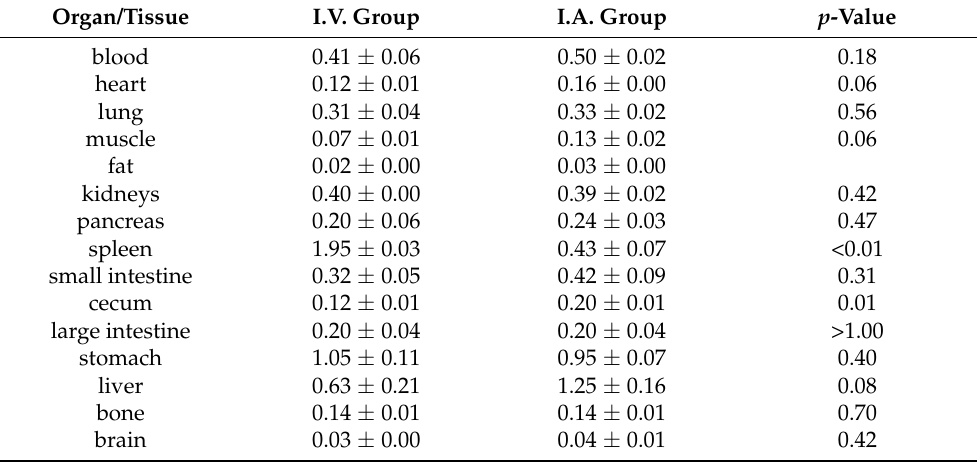
Figure 4. Comparative biodistribution of [ 124 I]I-UC-MSC-EVs for the I.V. group vs. the I.A. group after PET-CT scanning (96 – 98 min post injection). Rats were injected with ~8 MBq of [ 124 I]I-UC-MSC-EVs, and tissue biodistribution analyses were performed. * p <0.01. Table 1. Biodistribution of [ 124 I]I-UC-MSC-EVs uptake (%ID/gram) a in the I.V. and I.A. group. Organ/Tissue